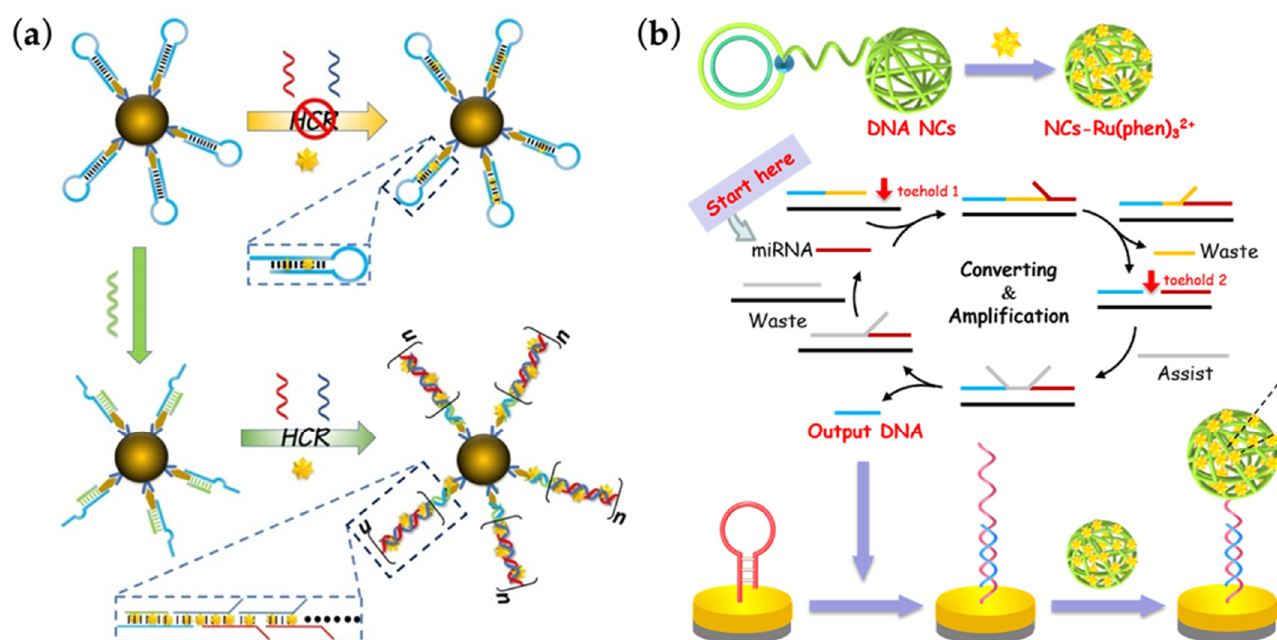
Figure 3. Mechanisms involved in the detection of AKI-related microRNAs (miRNA) with nucleic acid nanotechnology. ( a ) With the help of hybridization chain reaction, binding between miR-21 and capture strands leads to the exposure of a sticky end and a subsequent hybridization with other strands, eventually realizing double-stranded nucleotide elongation and an intensified loading of luminescent reporters. Adapted with permission from [33]. Copyright © 2022, Elsevier; ( b ) Schematic drawing of how toehold-mediated strand displacement facilitates the transformation and amplification of signals originating from the hybridization between miR-21 and substrate strands. Adapted with permission from [34]. Copyright © 2022, Elsevier.